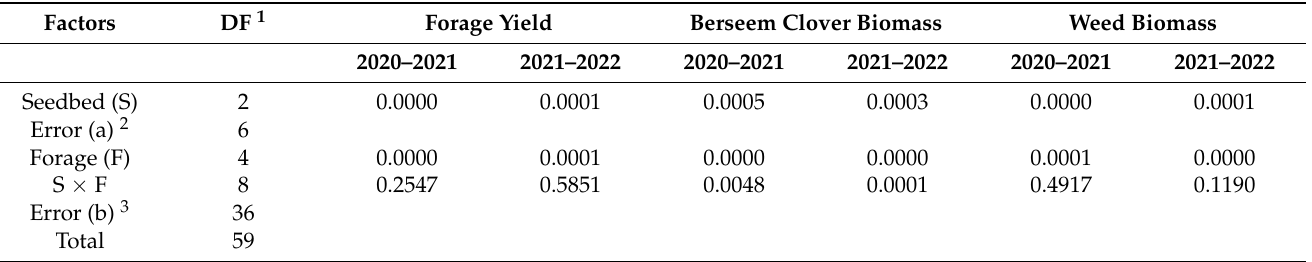
Table 4. Overall statistical analyses of degrees of freedom (for seedbed factor; for forage factor; for seedbed and forage interaction; for the error) and of the significance of effect (seedbed; forage; seedbed and forage interaction and tests performed) on forage yield, berseem clover, and total weed biomass. Data are presented separately for the two growing seasons (2020–2021 and 2021–2022). Forage Yield Berseem Clover Biomass